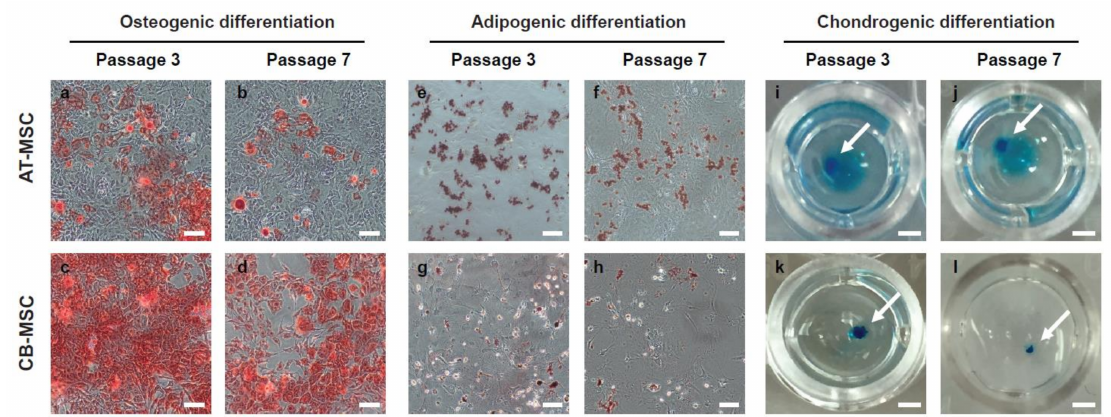
Figure 4. Osteogenic and adipogenic di ff erentiation of MSCs. AT-MSCs and CB-MSCs underwent 18-day of osteogenic, 14-day of adipogenic, or 21-days of chondrogenic di ff erentiation conditions. ( a – d ) Alizarin red staining, ( e – h ) Oil Red O staining, and ( i – l ) Alcian blue staining were used to assess osteogenic, adipogenic and chondrogenic di ff erentiation, respectively. Passage 3 of CB-MSCs displayed stronger staining for Alizarin red; whereas passage 3 of AT-MSCs displayed stronger Oil-Red-O staining. Late passage MSCs showed weaker staining in both lineage di ff erentiations. Chondrogenic di ff erentiation is comparable in both types of MSCs. The white arrows indicate the stained chondrocyte spheroids. Representative images were taken at 20 × ( a – h ) or 5 × ( i – l ) magnification. Scale bars: